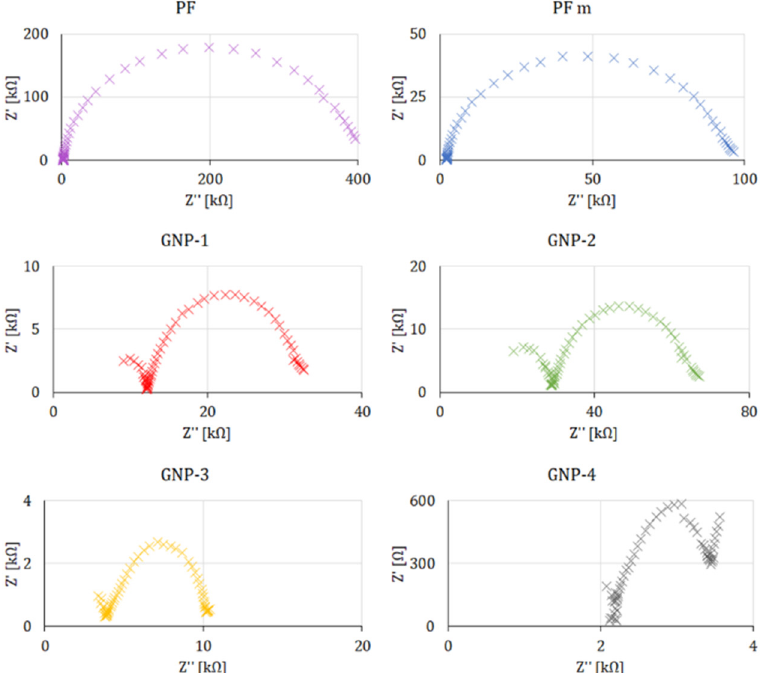
Figure 2 . CV measurements of SPEs fabricated with the examined pastes vs. Ag/AgCl/1.0 molL − 1 KCL reference electrode and a gold wire as the auxiliary electrode in 5 mM ferri/ferrocyanide in 0.1 M KCl solution; scan rate of 0.1Vs − 1.